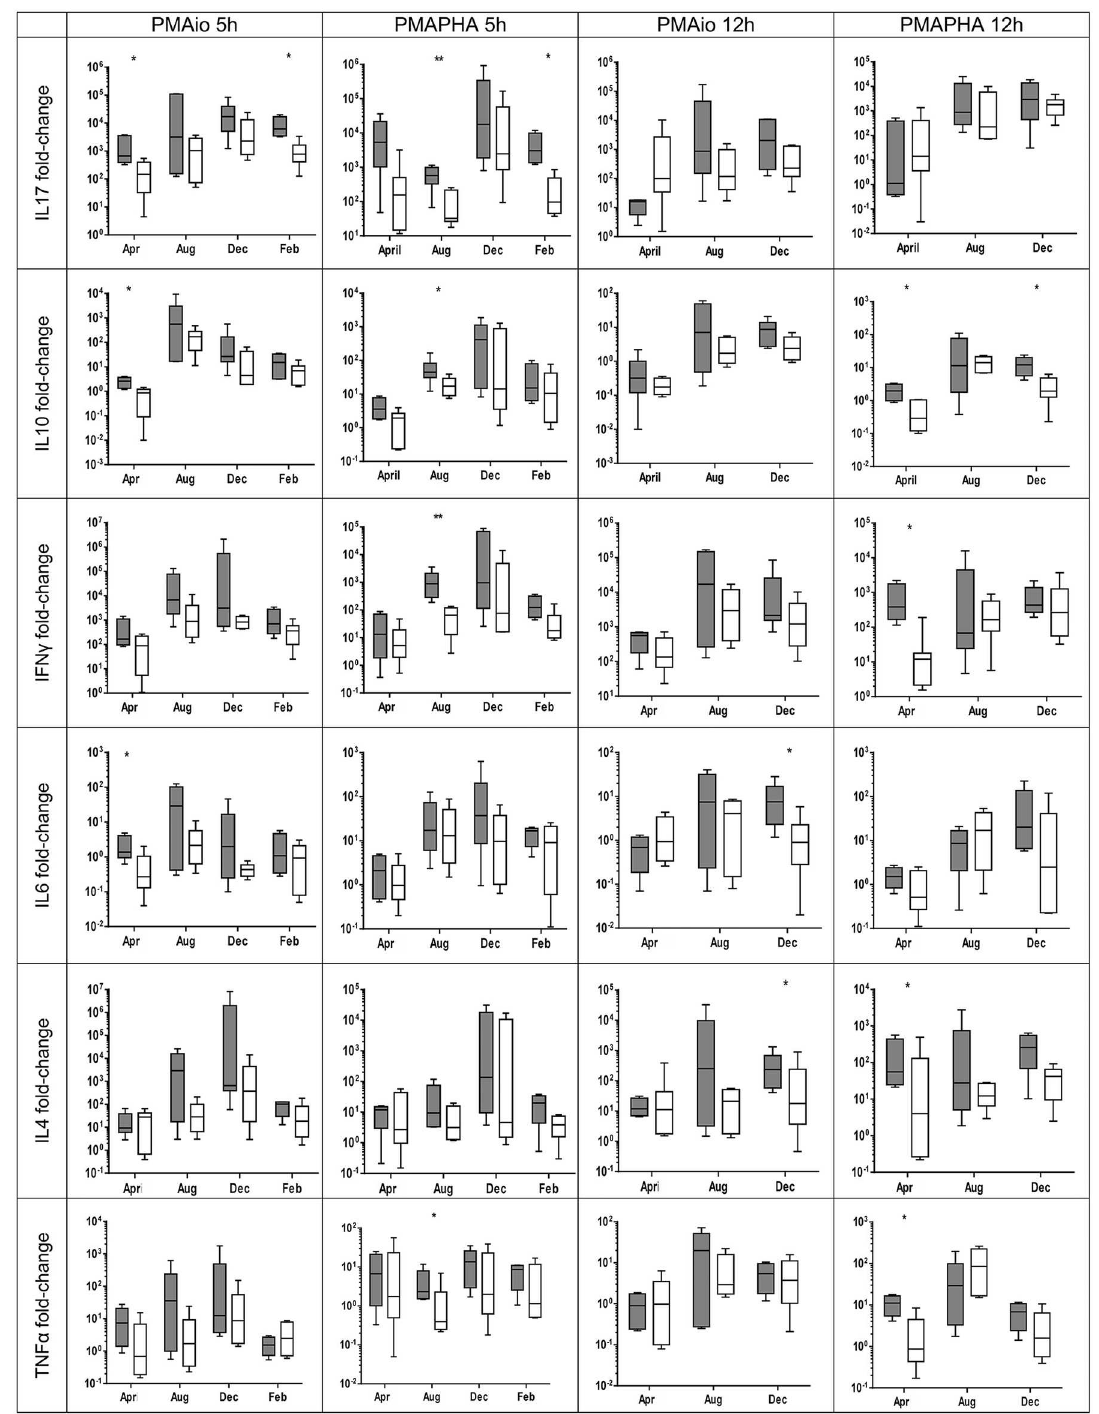
Fig 5. Cytokine fold change in KoRV B positive and negative groups by collection period. * p < 0 . 05 , ** p < 0 . 01 , *** p < 0 . 001 Mann Whitney U. White box is KoRV B negative and grey box is KoRV B positive. Results are expressed as fold change calculated using the ΔΔ Cq method [44]. Box represents the 25 th to 75 th percentiles, middle line is median and whiskers are the minimum to maximum values.